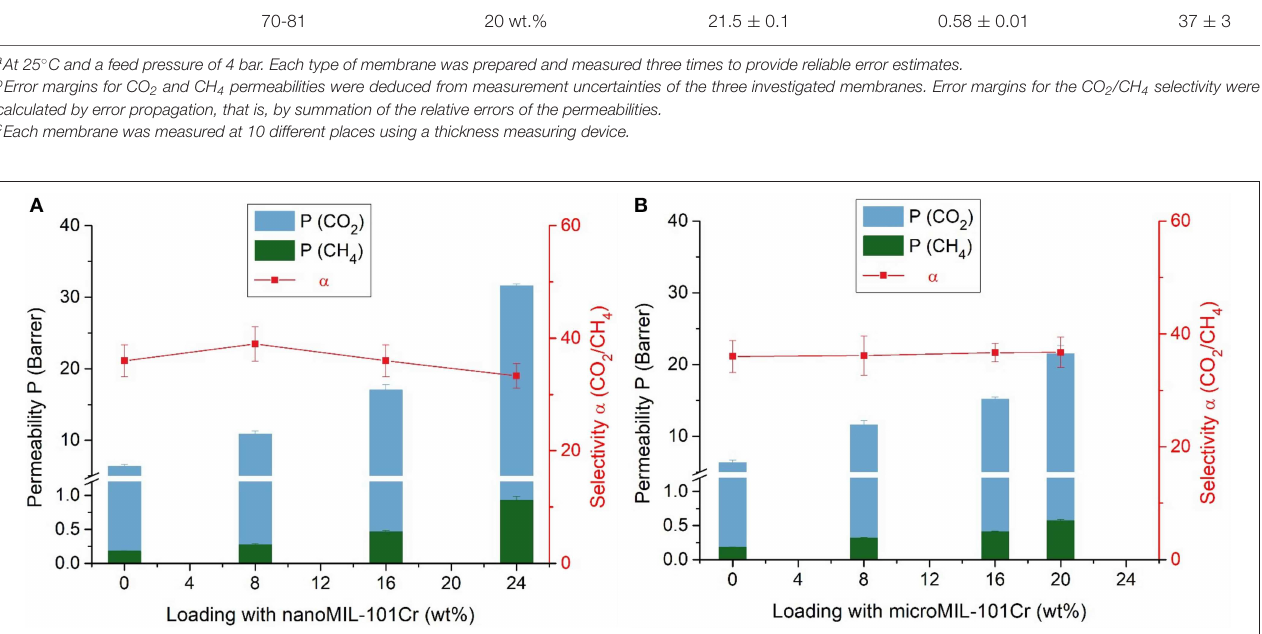
presented in Figures S29, S30 , yields slightly different